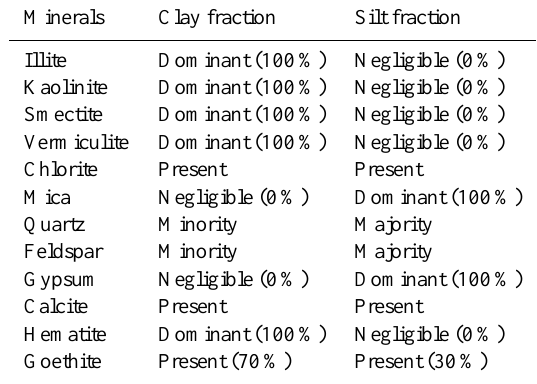
Table 1. Distribution of the selected minerals in the clay and silt fraction of